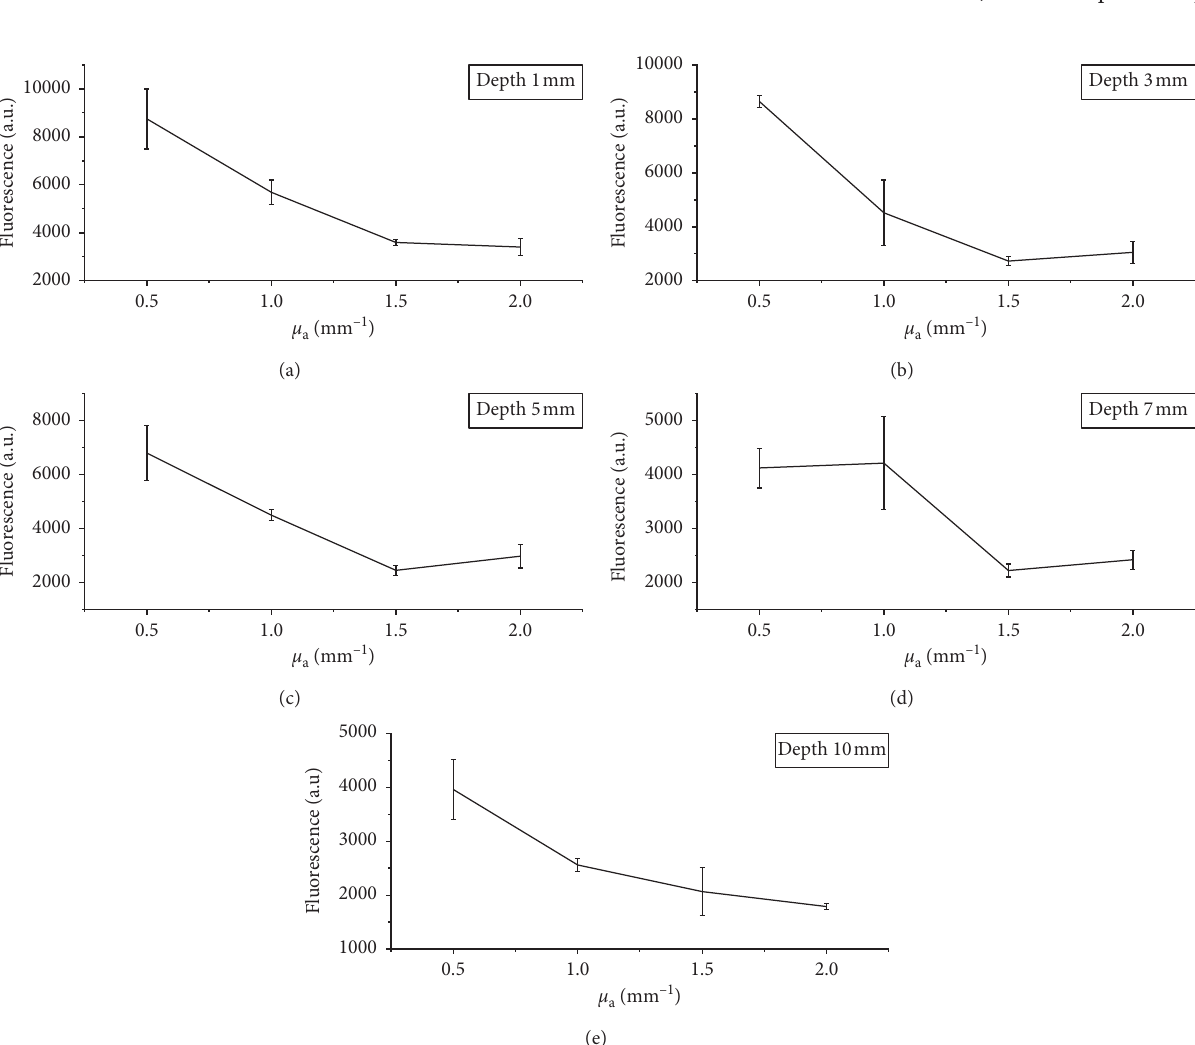
Figure 4: (a–e) Mean values and standard deviations of fluorescence intensity at 635nm as a function of absorption coefficient for different